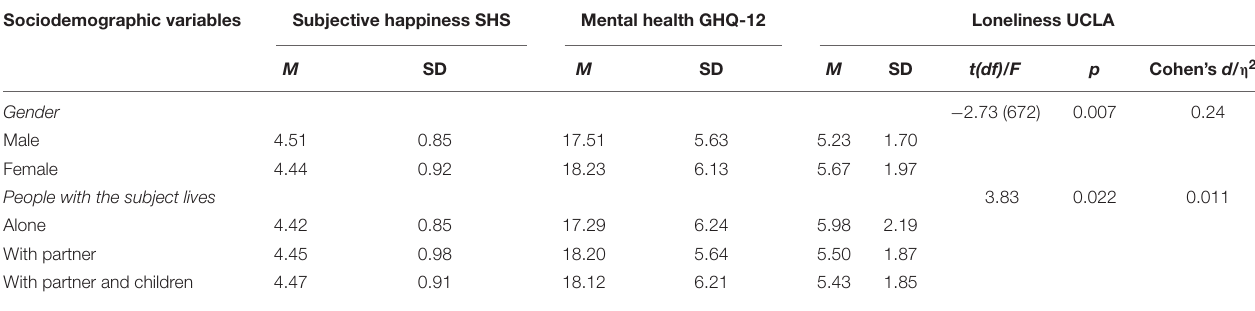
TABLE 2 | Descriptive statistics of variables of the sample ( N =